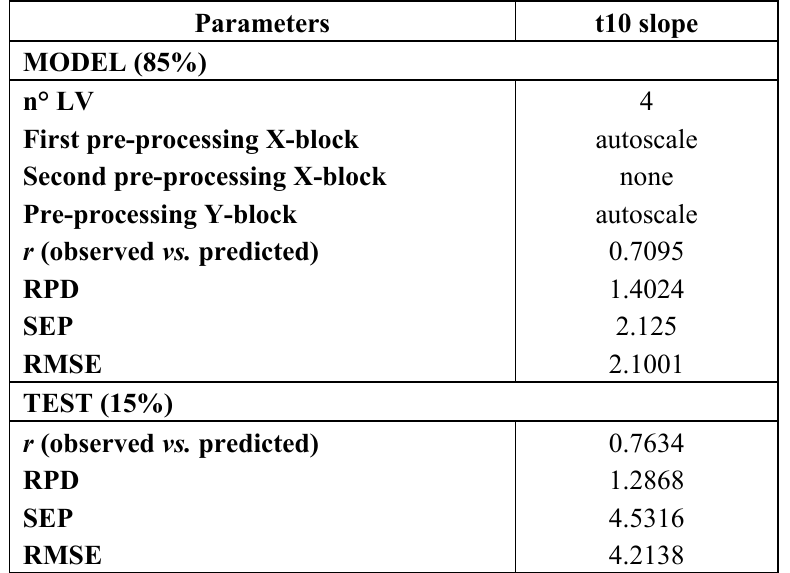
Table 3. Results of Partial Least Squares (PLS) for the prediction of soil water content (SWC) obtained with laboratory thermometric analysis for the interval t table are reported: n° of Latent Vectors (LV); first and second pre-processing for the X-block and one for the Y-block; the correlation coefficient ( r ); the Ratio of Percentage Deviation (RPD); the Standard Error of Prevision (SEP) and the Root Mean Square Error (RMSE) for the model and test.